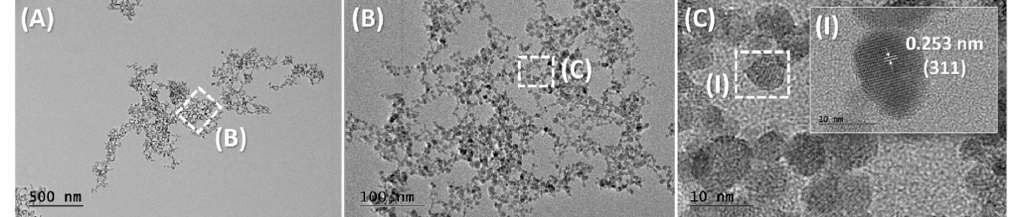
Figure 1. Transmission electron microscopy (TEM) images of nanocrystalline magnetite nanoparticles, in different magnifications ( A – C ). (I) Inset: Overfocused high resolution transmission electron microscopy (HRTEM) image of magnetite nanoparticle highlighting the interplanar distance of 311 plane (Scale bar: 10 nm).